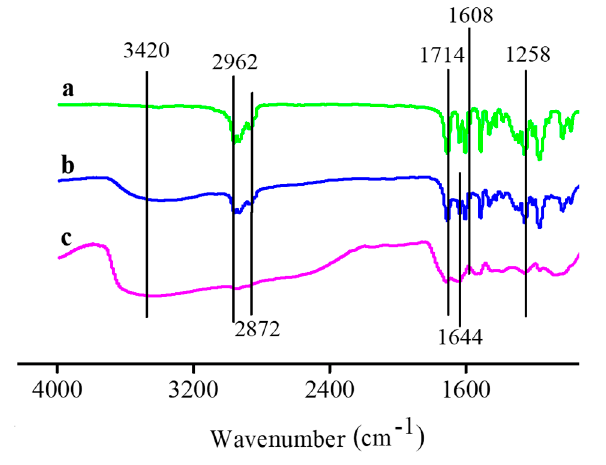
Figure 9. Fourier transform infrared (FTIR) spectra of OMC ( a ), OMC microcapsules ( b ), and the SC/GA ( c ).